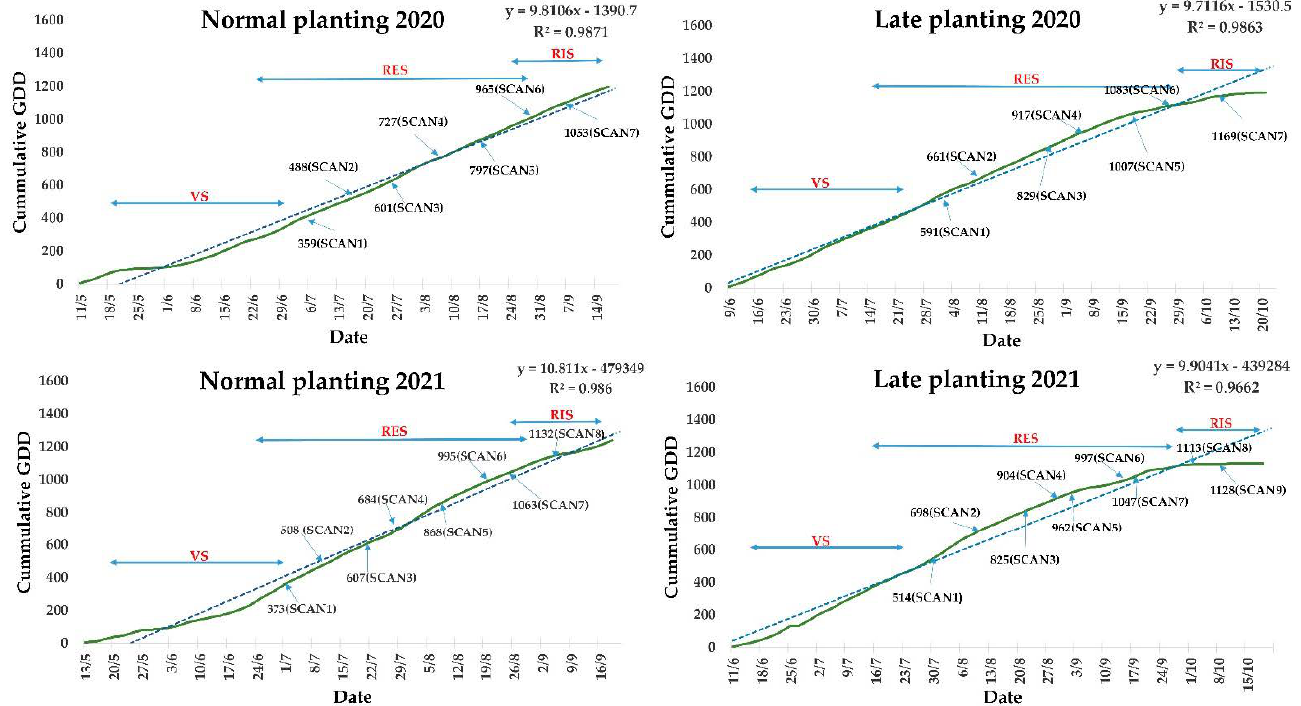
Figure 4. Pattern of GDD accumulation rates for both growing conditions and cropping years. Shown is the fitted linear regression line for the GDD parameters, along with the equations and R 2 . Scanning dates in dependence with GDD and sesame phenology phases (VS = vegetative stage, RES = reproductive stage, RIS = ripening stage).